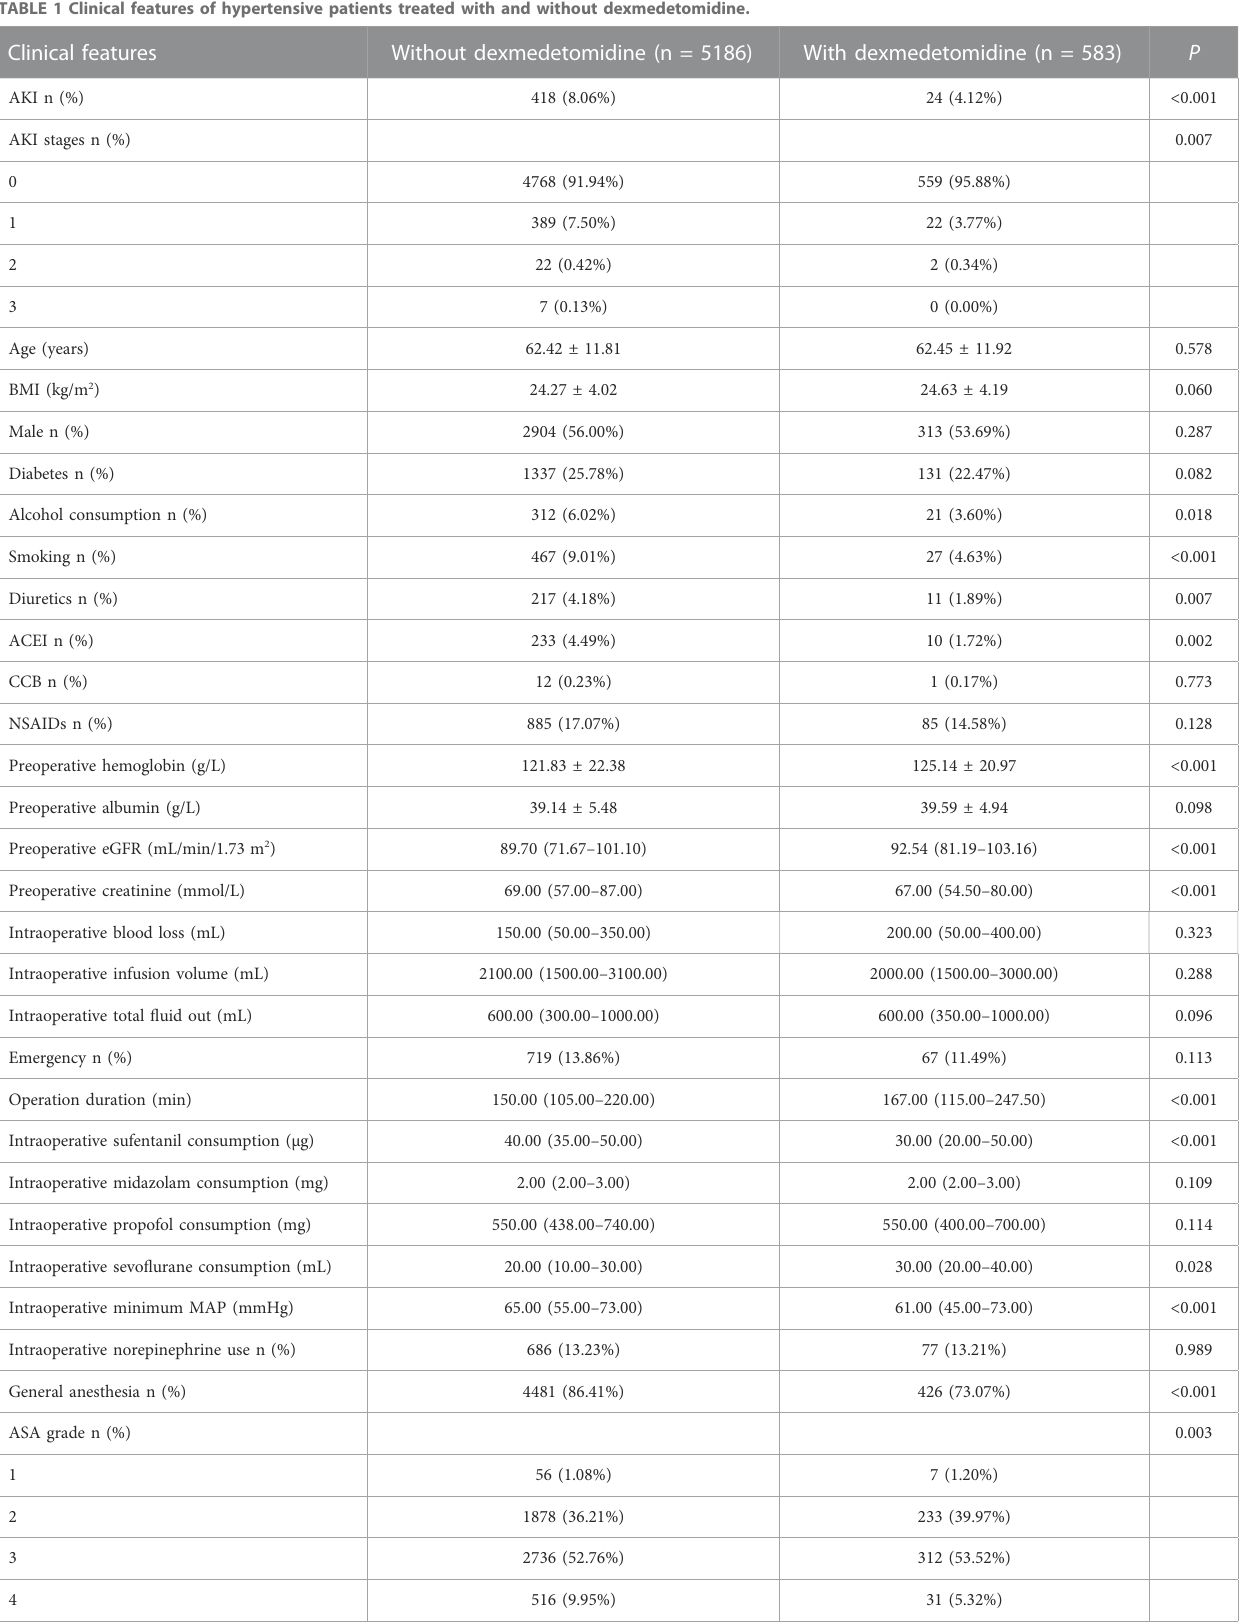
TABLE 1 Clinical features of hypertensive patients treated with and without